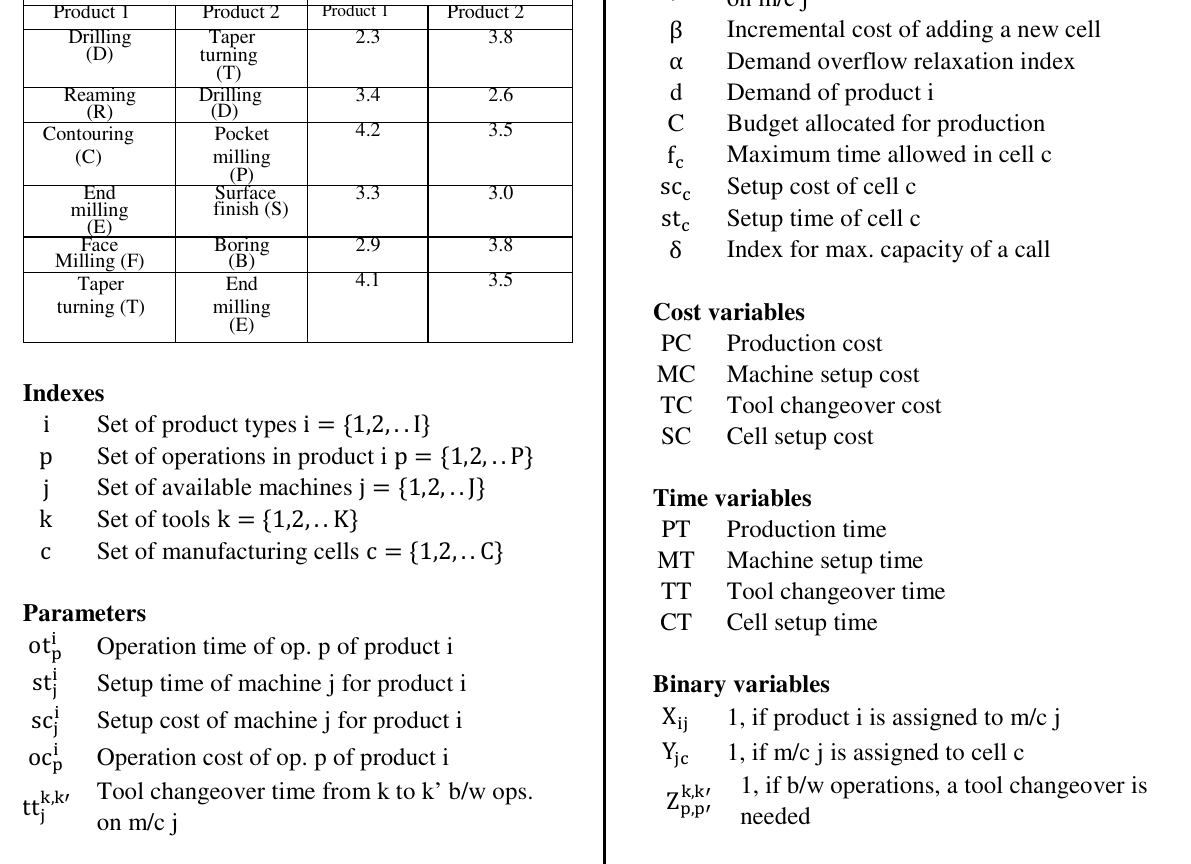
Table 2: Operational details for each product